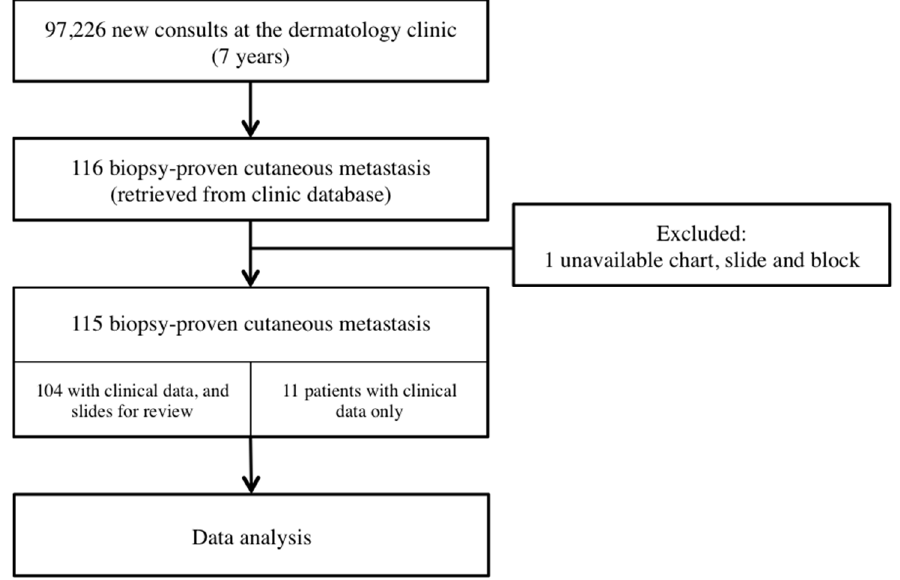
Figure 1. Study flowchart.